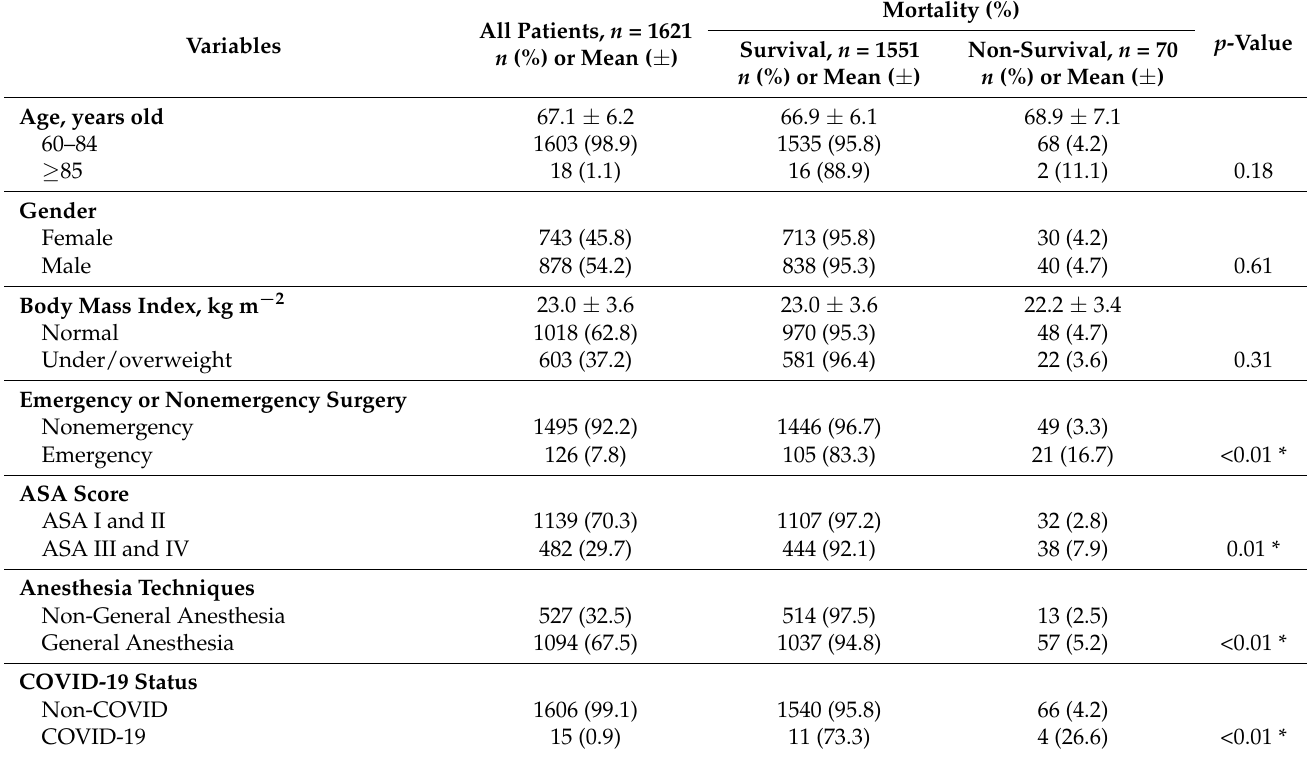
Table 2. Demographic data of geriatric patients with mortality and univariate